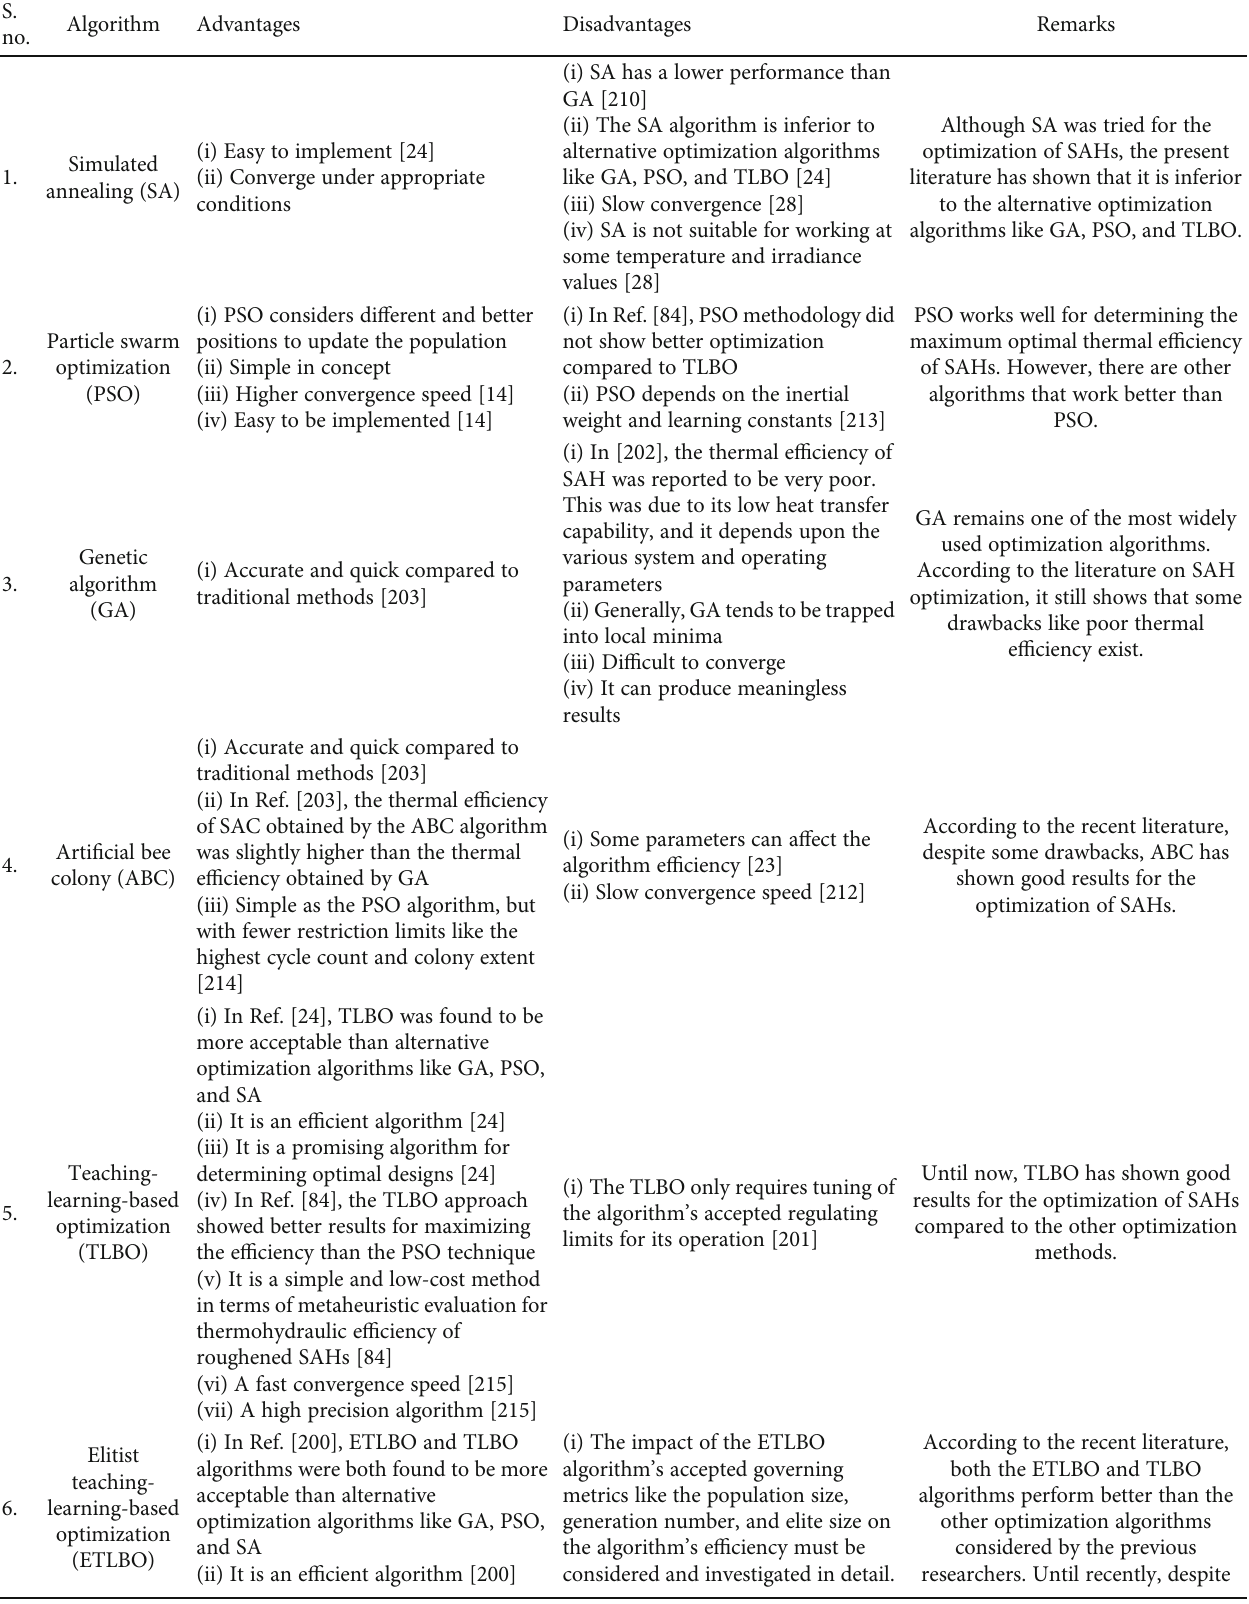
Table 5: Summary of the advantages and disadvantages of six discussed methods in SAH optimization.